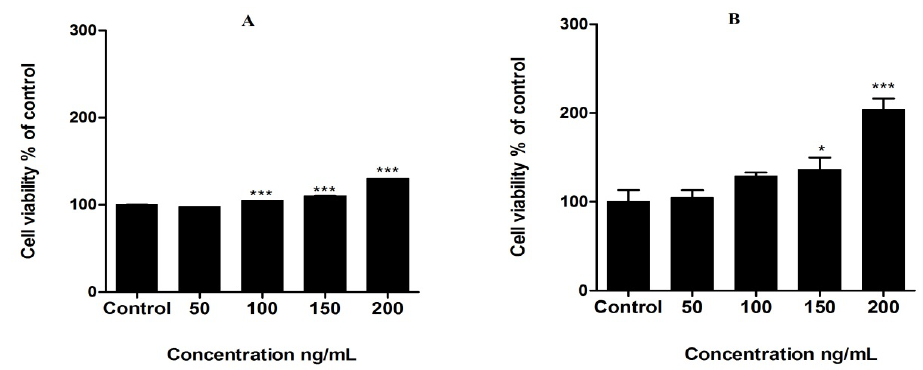
Figure 1. MCF-7 breast cancer cell viability after exposure to leptin for 48 h. ( A ) MTT assay ( B ) fluorometric assay. * p < 0.05, *** p < 0.0001 compared to the controls (one way ANOVA followed by Bonferroni test for selected pairs).